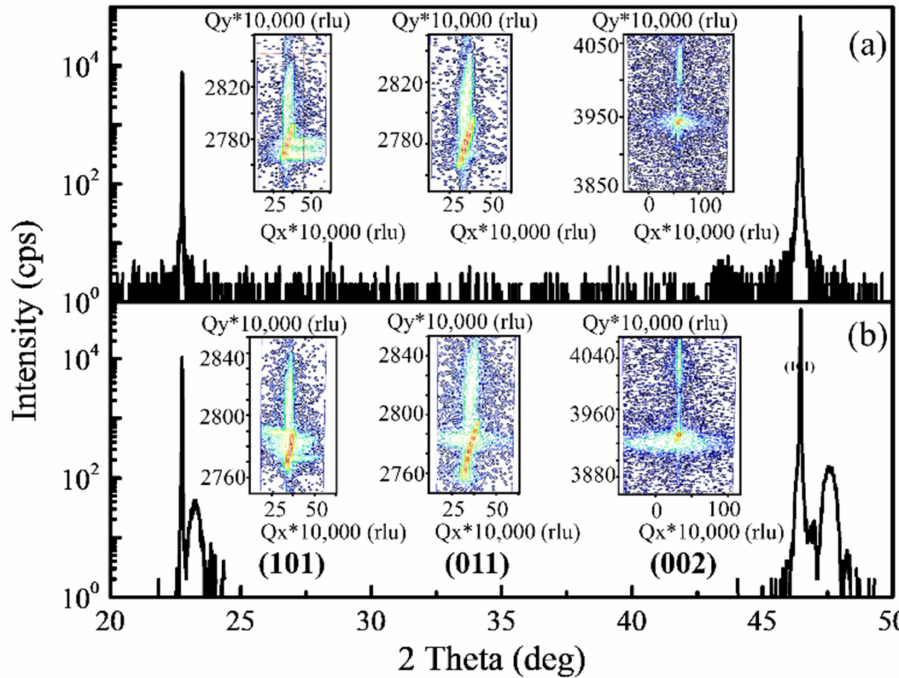
Figure 1. XRD patterns of ( a ) the as-prepared PBCC film deposited on the (001) SrTiO 3 substrate and ( b ) the PBCC films after annealing under O 2 at 700 ◦ C for 8 h. The insets are the corresponding RSMs of the as-prepared PBCC film.